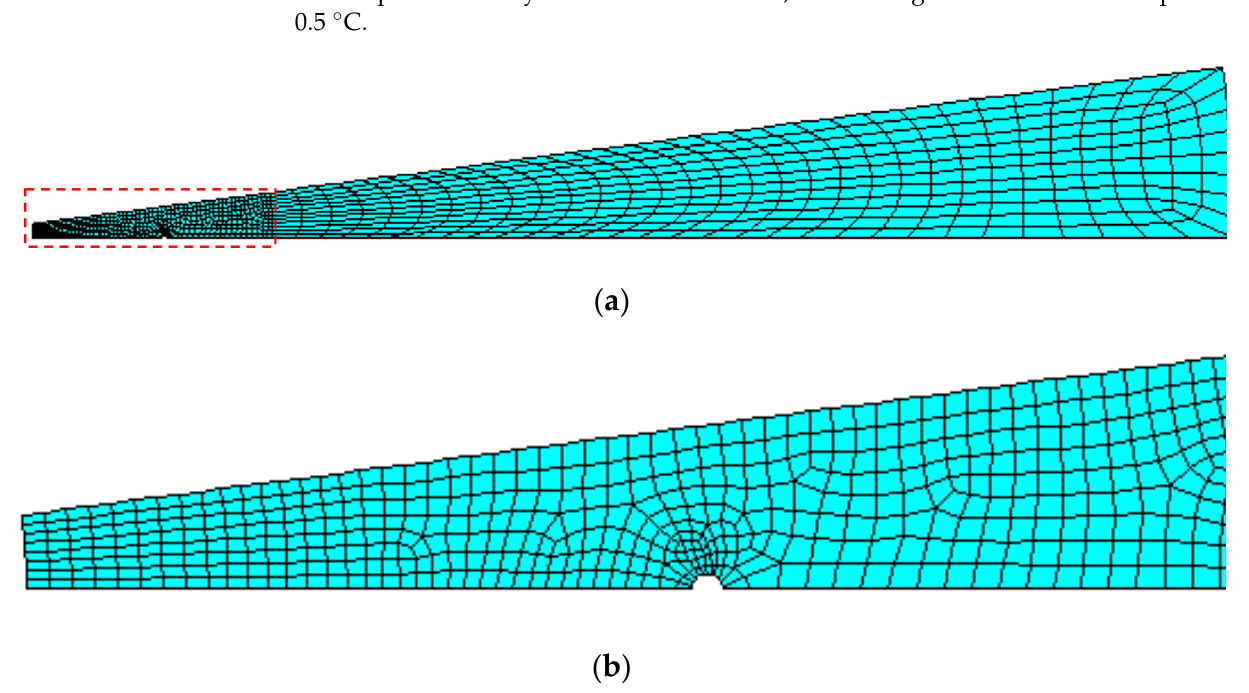
Figure 6. Meshing in the freezing temperature field calculation: ( a ) the general diagram, ( b ) the partial enlarged drawing.